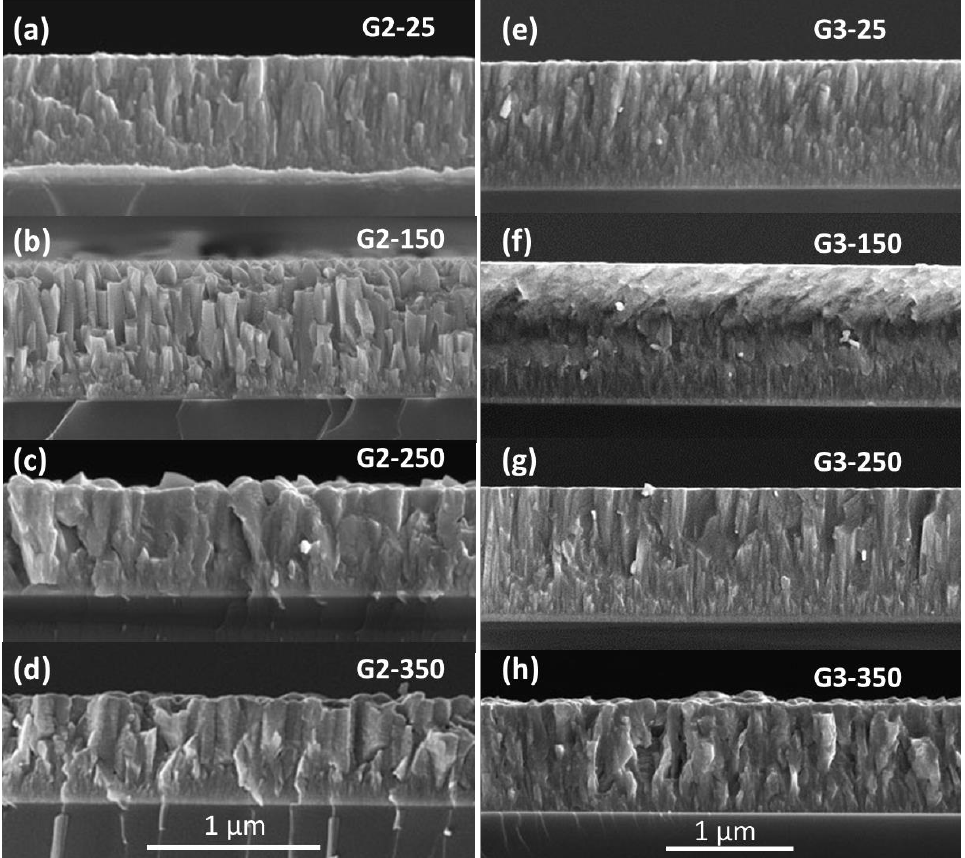
Figure 6. SEM cross-section secondary electron images for films deposited from groups 2 and 3. Films shown in ( a – d ) are from group 2, and show the development of coarse, faceted crystals with rough film surfaces. Films in ( e – h ) show improved film density with smoother surfaces, although some coarsening and roughening is observed at 350 °C.